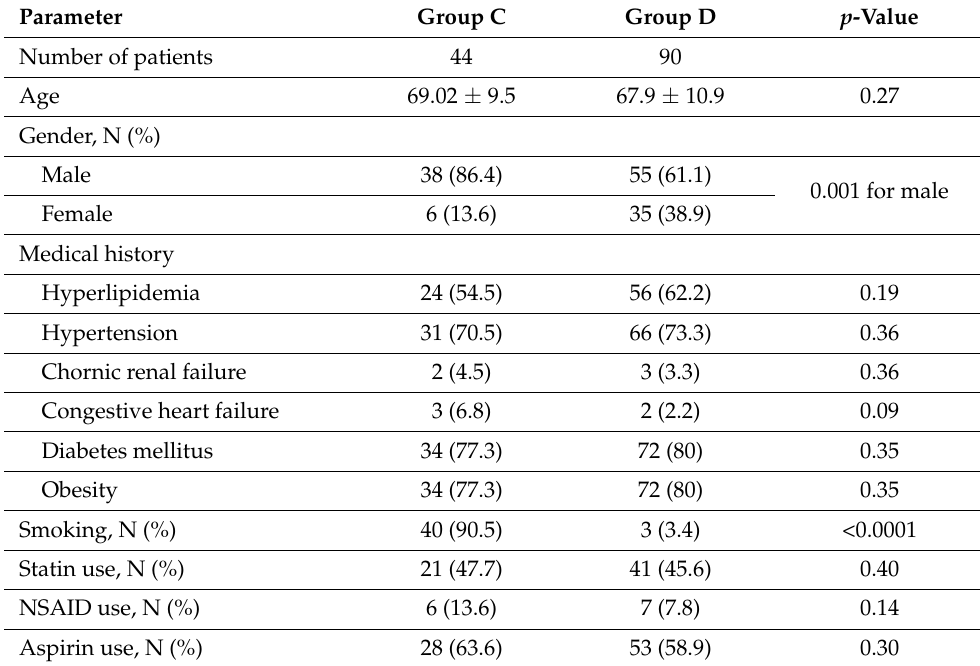
Table 3. Demographics and baseline characteristics of patients who had acute